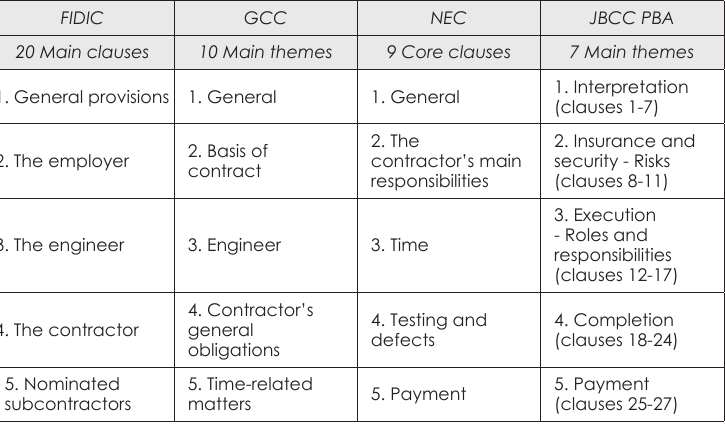
Content comparison between the four main contracts